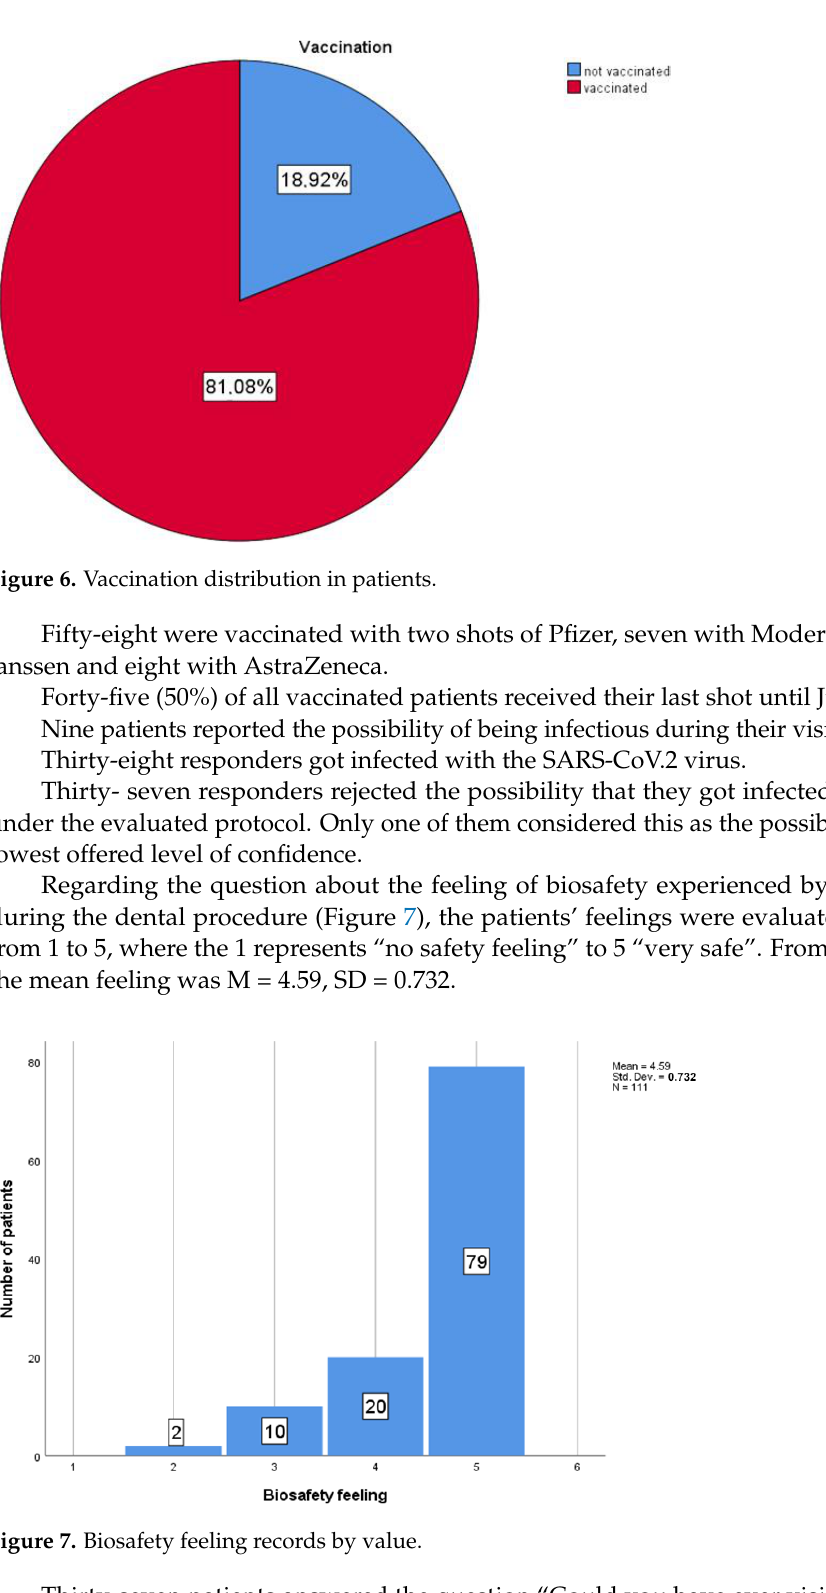
Figure 8. Number of subjective infectious status during visit. Figure 9. Potential infectious patients during the visit and spectrum of their symptoms. 3.2. Graphical Interpretation of Clinical Evaluation of the Protocol Out of 111 patients, 56 (50.5%) were exposed to SARS-Co-2 infection and 55 (49.5%) were not (Figure 4). The incidence of exposure to an infected person is shown in Figure 5. The one-sample t test revealed a significant difference in the distribution of the expo- sures t (51) = 7,103,185, p < 0.001 during the time (M = 14.7.2021; SD = 162 d).